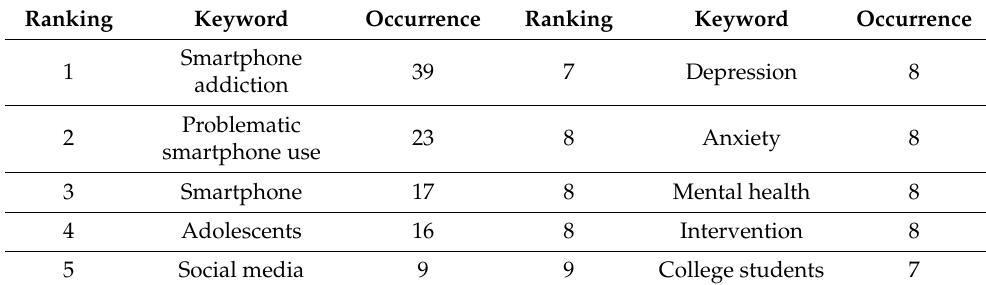
Table 7. Occurrence of keywords.